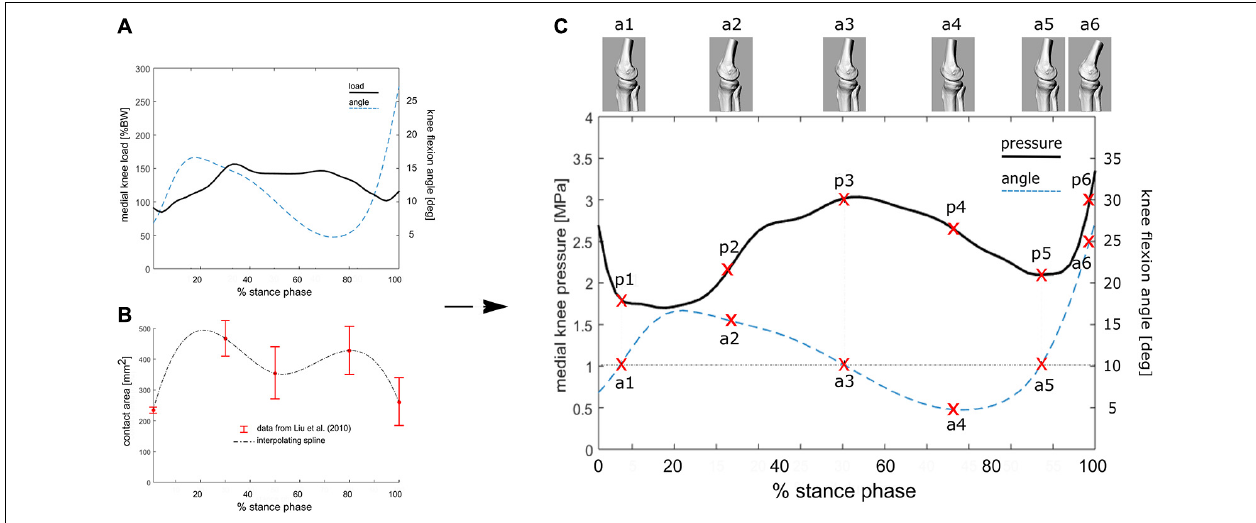
FIGURE 2 | (A) Knee flexion angle and the estimated internal tibio-femoral joint forces during stance phase of walking using the linear relationship between EAM and knee forces reported in the equation. EAM and knee kinematics were calculated as the average across five walking trials for a subject with knee OA. (B) Interpolated temporal profile of cartilage contact area over stance phase duration, using data from Liu et al. (2010). (C) Estimated temporal profile of tibio-femoral contact pressure over stance phase of walking for the knee OA patient; the curve is obtained by dividing the contact force (A) by the contact area (B) . 3D representations of the tibio-femoral joint angle (a1–a6) at different time frames are shown. The knee is flexed 10 ◦ at three times of the of the stance phase, while the relevant cartilage region is subjected to pressure p1, p3 and